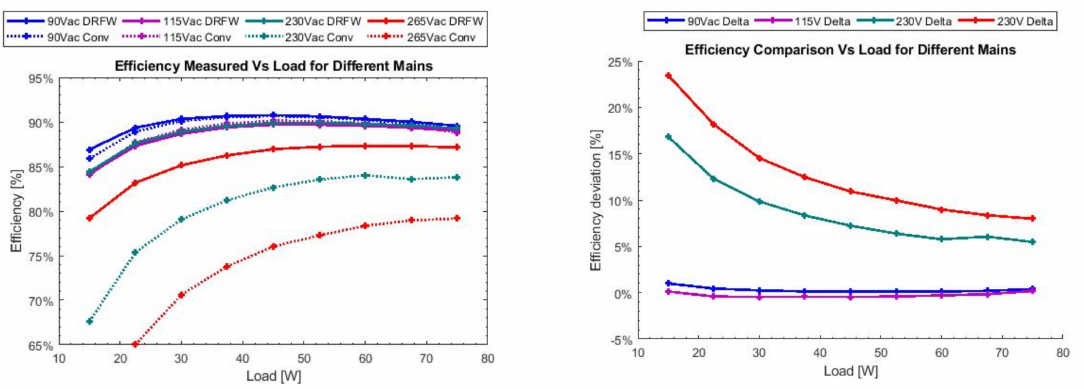
Figure 10. DVFW and conventional converter efficiency comparison ( left ) and efficiency deviation ( right